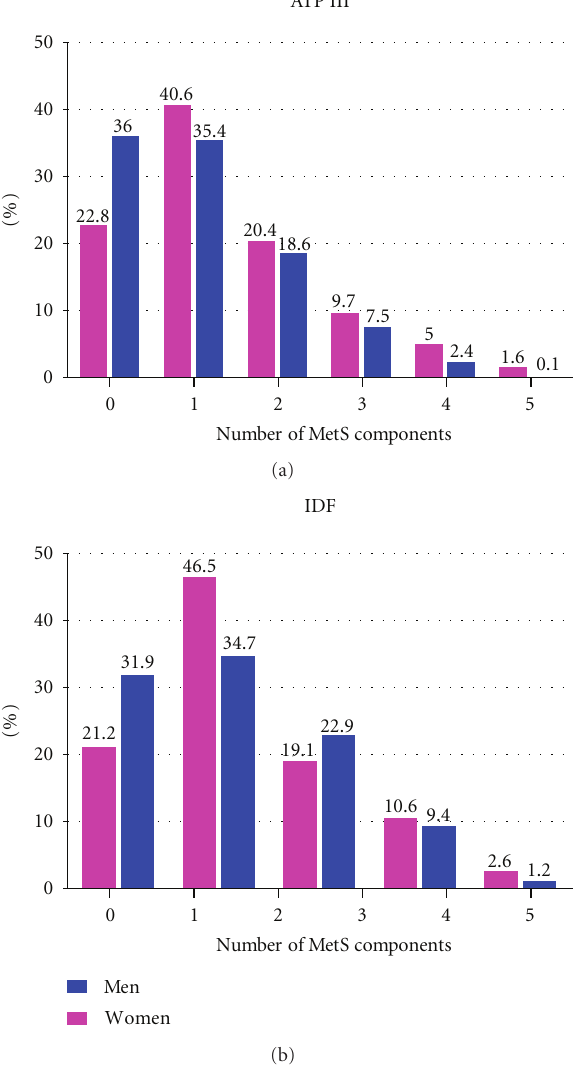
Figure 2: Number of metabolic syndrome components by gender according to ATP III and IDF